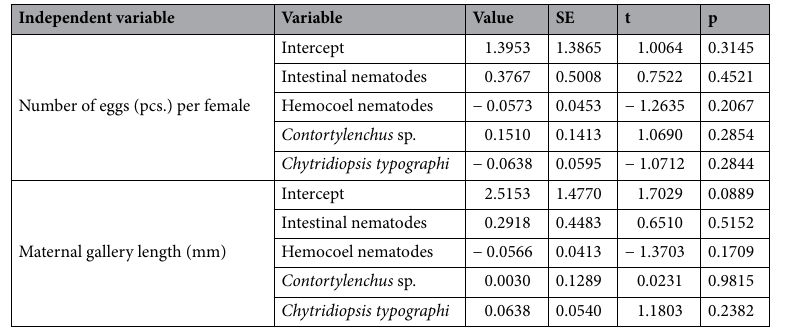
Table 5. Relationships between the number of eggs (pcs.) per I. cembrae female or maternal gallery length (mm) and the presence of different groups of antagonists as indicated by GLMMs.